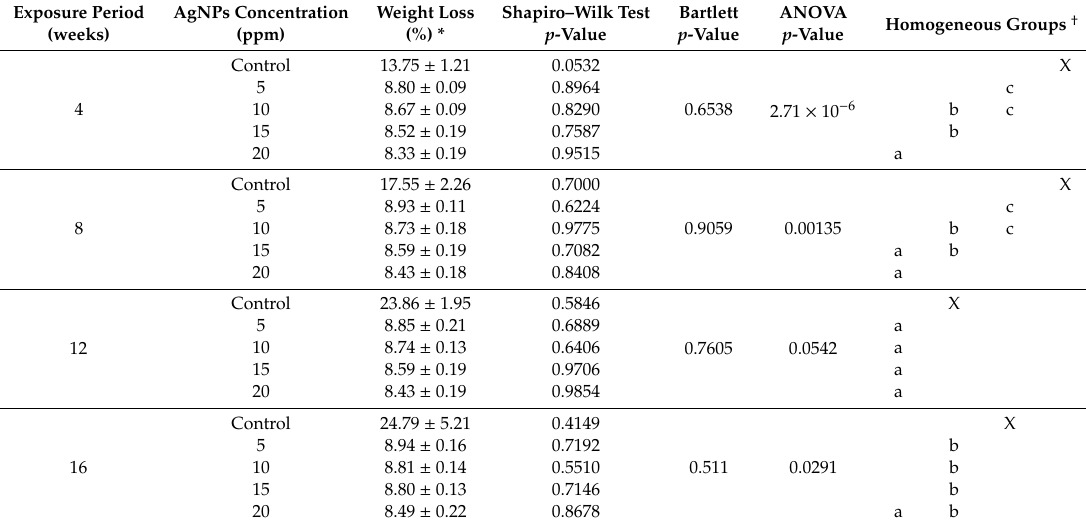
Table 2. Weight loss after di ff erent incubation periods for the silver nanoparticles treatments. Exposure Period (weeks)